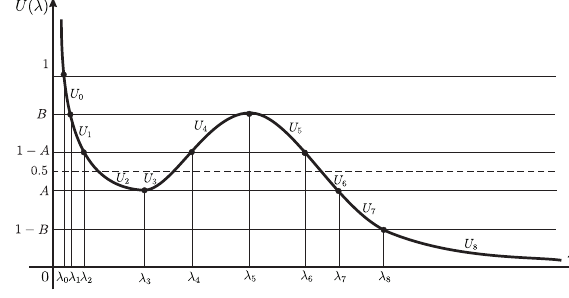
Figure 3. Subdivision of the λ